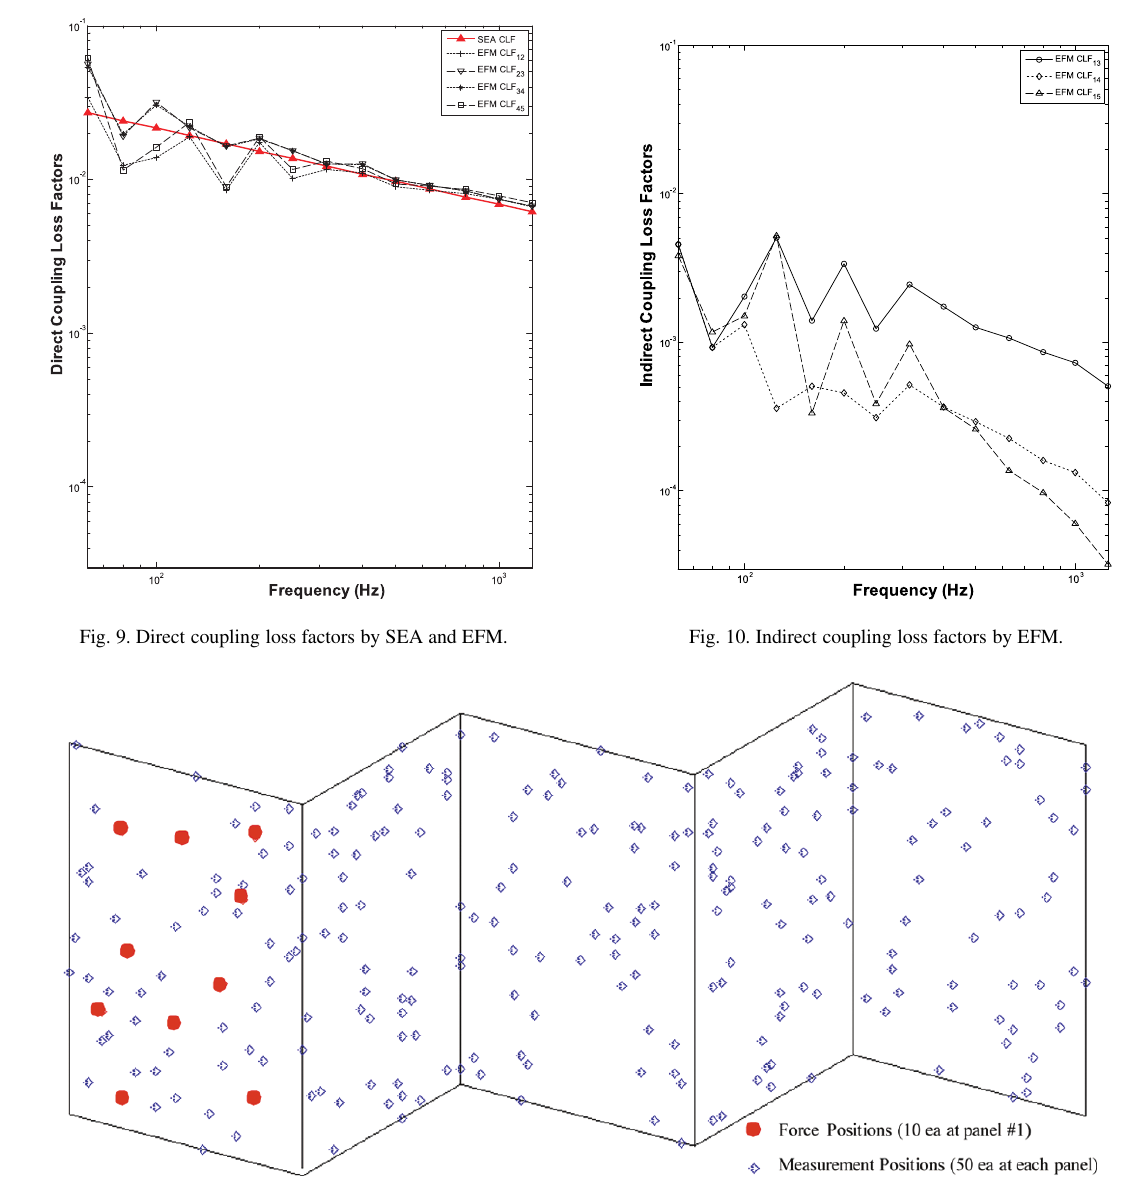
Fig. 11. Numerical simulation